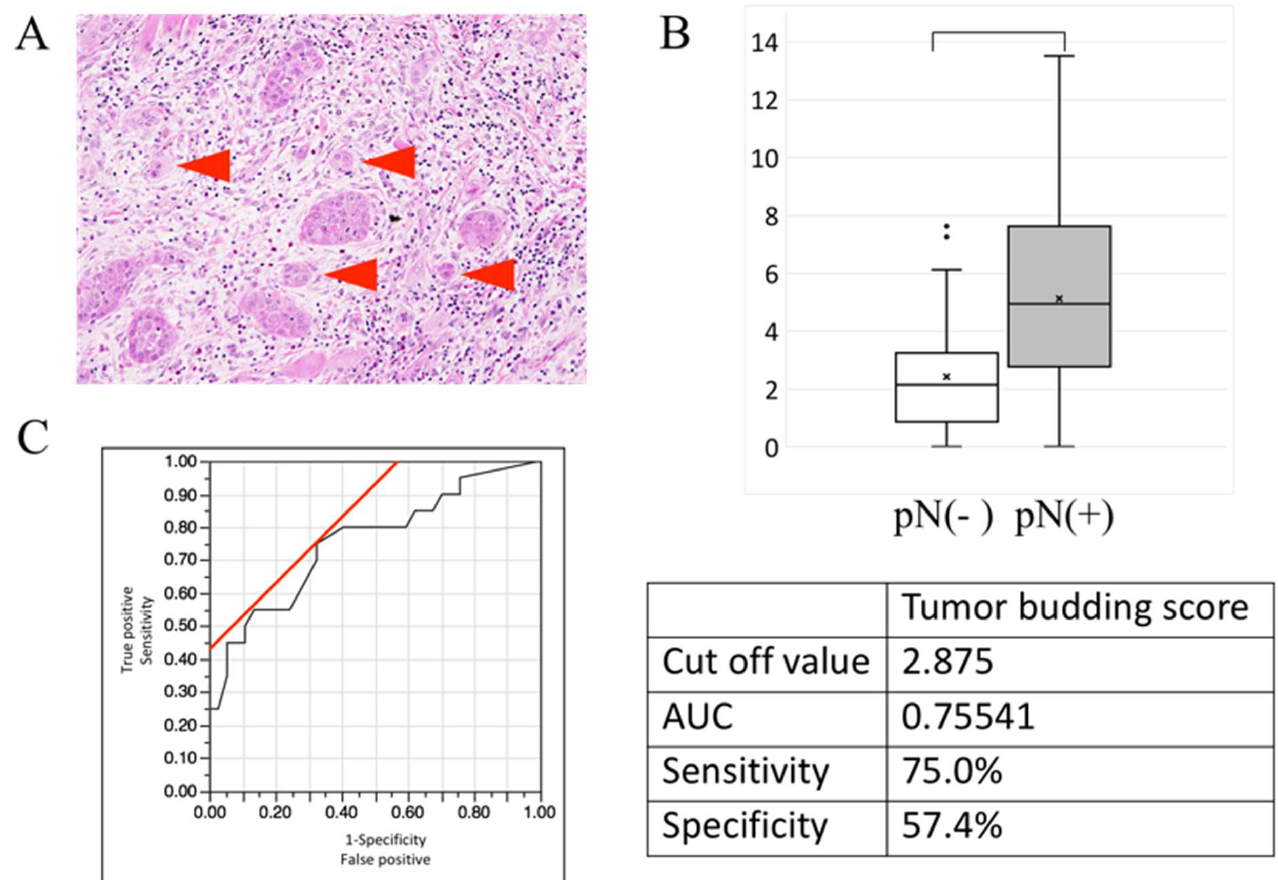
Figure 2. ( A ): Histopathological finding of tumor budding in biopsy specimen with hematoxylin